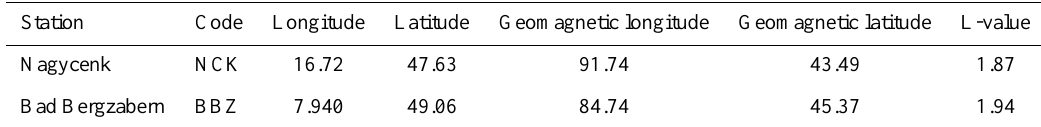
Table 1. Stations used and their co-ordinates.